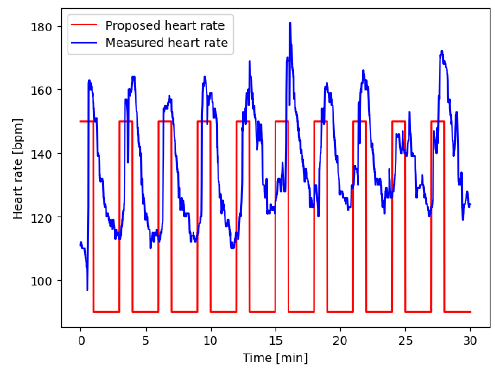
Figure 5. Amateur sport training.